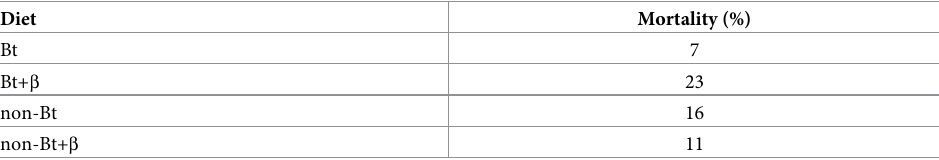
Table 1. Mortality of the Helicoverpa armigera F1 larvae. Diet Mortality (%) Bt 7 Bt+ β 23 non-Bt 16 non-Bt+ β 11 Percentage mortality of Helicoverpa armigera F1 larvae fed on Bt or non-Bt diets with or without β -carotene supplementation during all